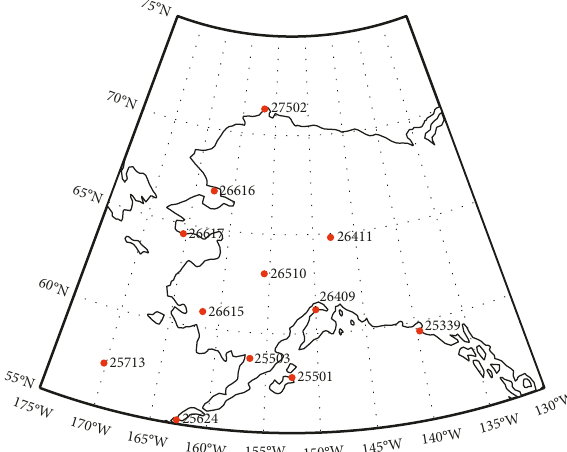
Figure 1: Geographic location of 12 observation stations in the Alaska